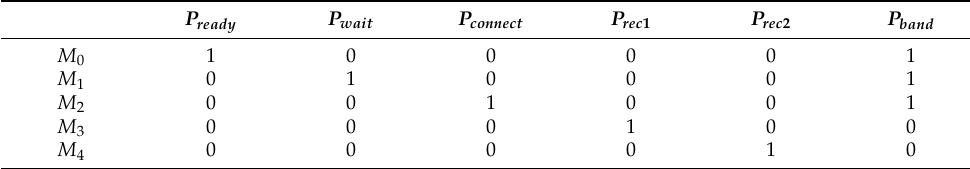
Table 3. Reachable marking set of the SPN